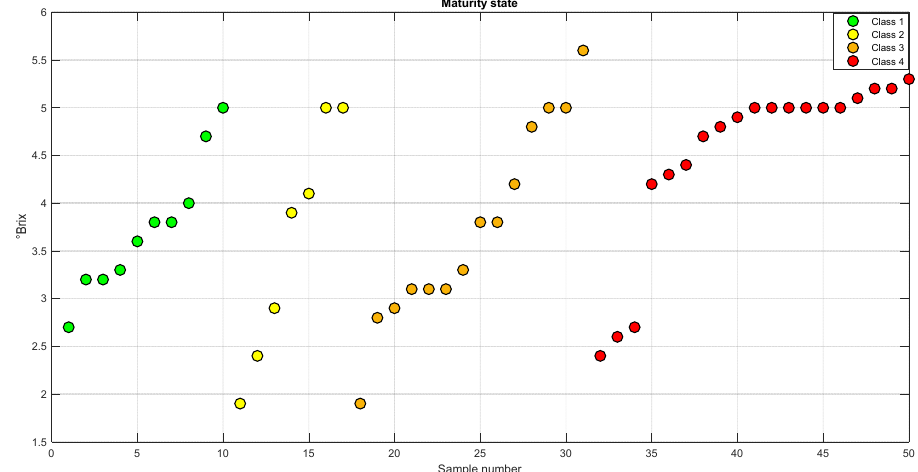
Figure 1. Distribution of Brix Grades in di ff erent stages of maturity.